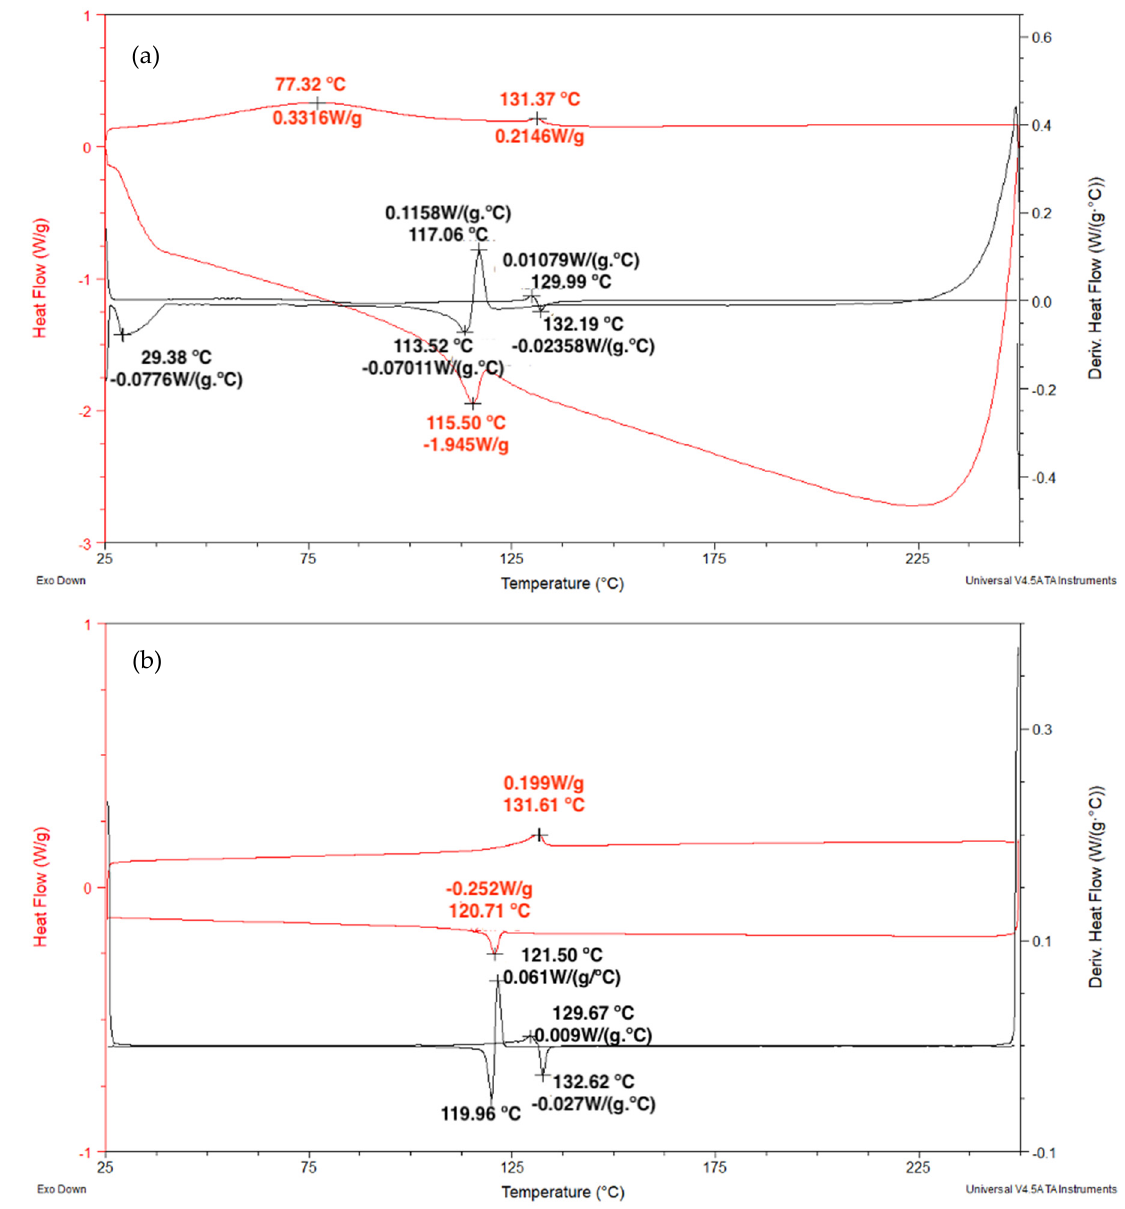
Figure 9. DSC curves obtained for the epoxy resin composite reinforced with GO and ramie fabric: first ( a ) and second ( b ) heating and cooling cycles.